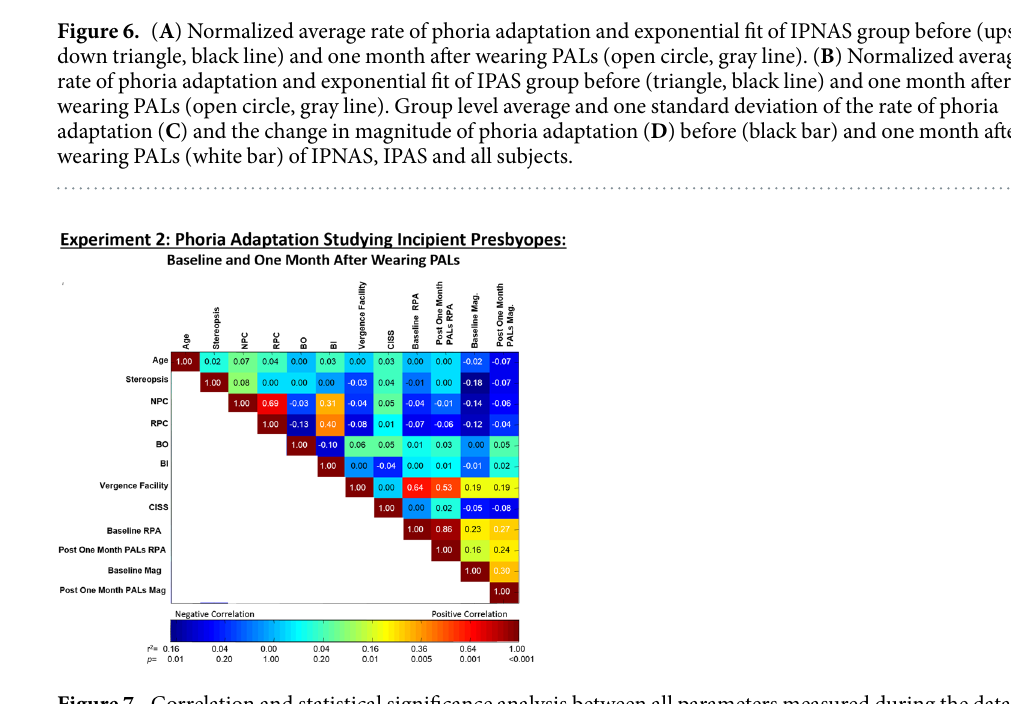
technique to determine which patients will likely adapt to PALs and which patients will have a difficult time. We consider three main parameters for patients who are prescribed PALs, namely an increased ability to change 4° disparity-convergence peak velocity during a short-term modification experiment, an increased rate of phoria adaptation, and greater vergence facility.